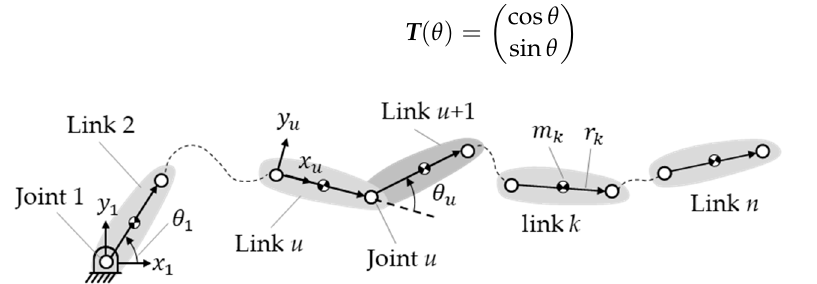
Figure 1. A typical joint u in an n -link manipulator.